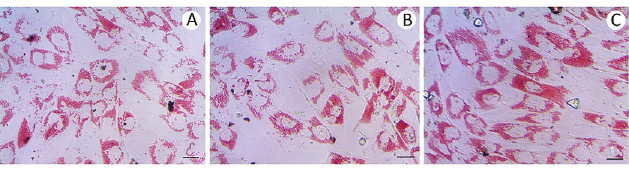
Figure 2 - Representative images of cultured dermal fibroblasts exposed to different concentrations of the food additive E407a (A - 0 µg/ml; B - 100 µg/ml; C - 5 mg/ml) for 24 h and subsequently stained with the neutral red dye. Phase contrast microscopy. The scale bar is 100 µm.